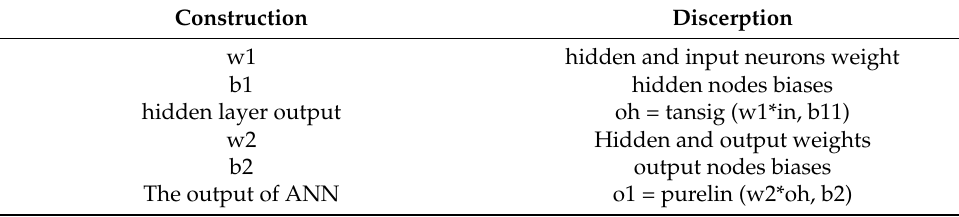
Figure A5. Structure of the ANN for the LMPC-ANN controller. Table A1. Structure of the ANN.